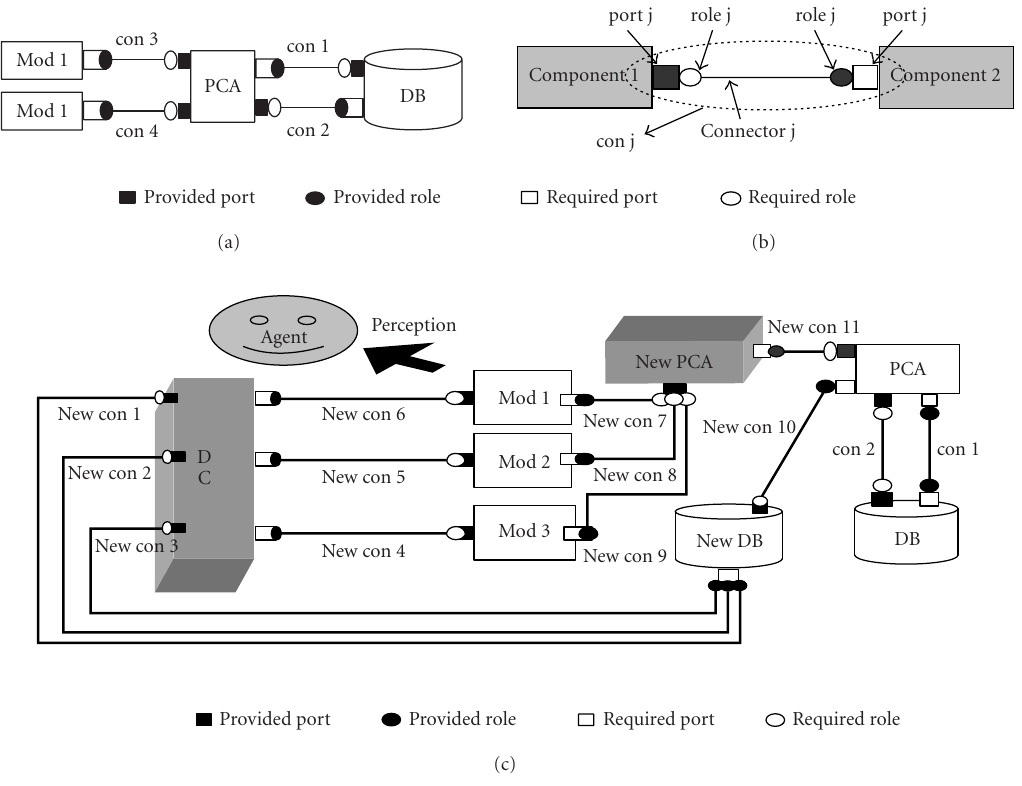
Figure 12: (a) The initial architecture. (b) Connection j (con j). (c) The final desired architecture. (Mod: modality, Cl: collector, D: